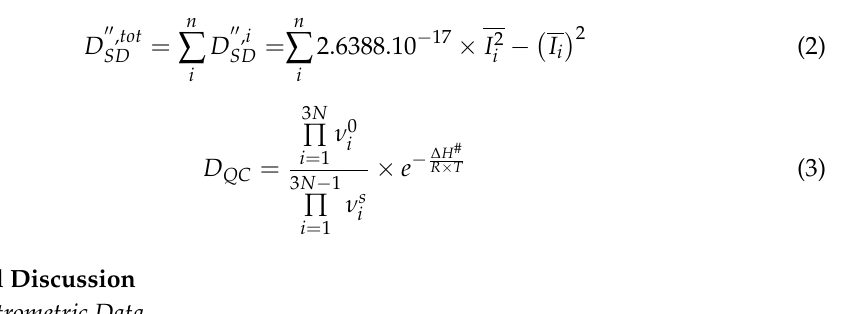
Figure 3. The total ion current ( top ) of standard sample of wet biota; CID - MS/MS spectrum of molecular cation [M+H] + at m / z 152 of paracetamol ( bottom ) .